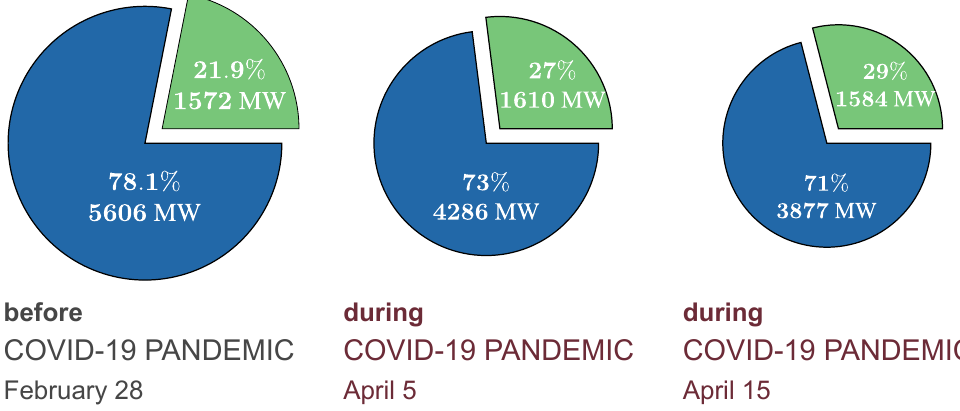
Figure 3. Maximum share of renewable energy in Israel before and during the first lockdown (2020), as a fraction of total